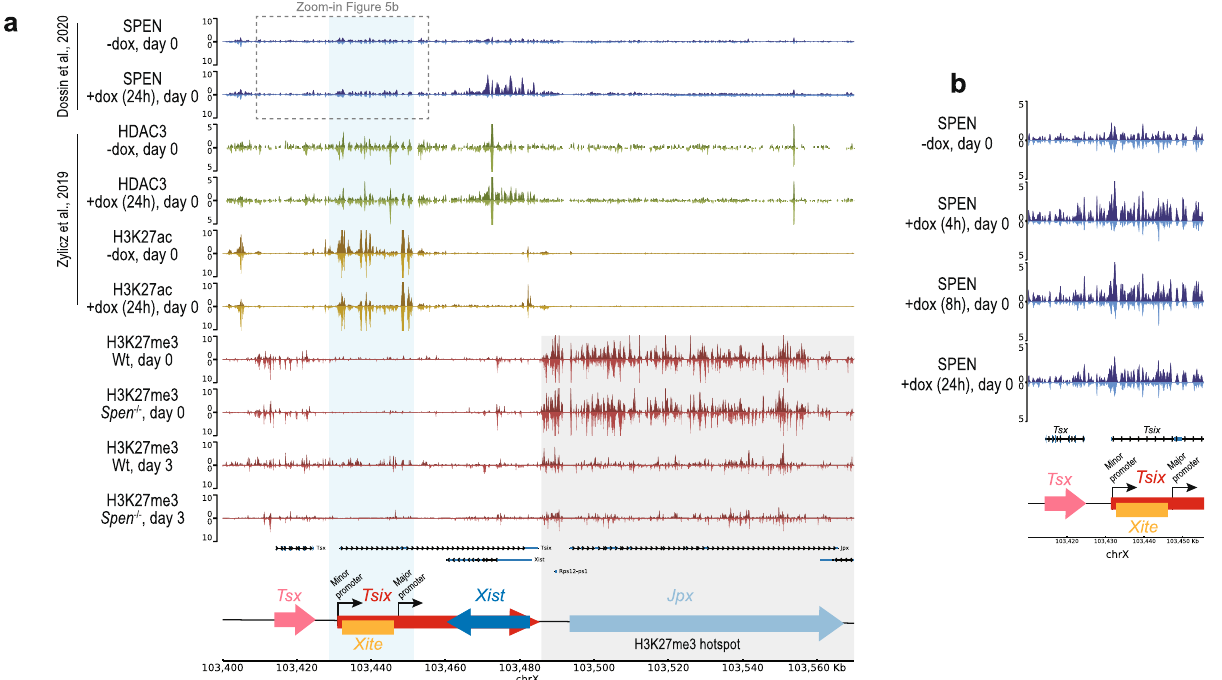
Fig. 5 Tsix -regulatory region shows SPEN, HDAC3 and H3K27ac enrichment. a Genome browser tracks showing allele-speci fi c SPEN, HDAC3, H3K27ac and H3K27me3 binding at the Xist – Tsix locus. The top part (dark) of each track represents the Xi and the bottom (light) the Xa. SPEN CUT&RUN (blue, top) pro fi le in Xist- inducible undifferentiated ESCs (day 0) untreated or treated with doxycycline (24 h) 25 . HDAC3 (green, middle – top) and H3K27ac ChIP- seq (yellow, middle – bottom) in Xist- inducible undifferentiated ESC (day 0) untreated or treated with doxycycline (24 h) 29 . H3K27me3 ChIP-seq (red, bottom) in Wt and Spen − / − ESCs at days 0 and 3 of monolayer differentiation. The light-blue rectangle highlights the Tsix regulatory region, including the Tsix minor and major promoters, and Xite . The light-gray rectangle highlights the H3K27me3 hotspot region. The dashed rectangle indicates the genomic region in (b). b Zoom-in view of the Tsix promoter region, showing the SPEN CUT&RUN pro fi le in undifferentiated ESCs (day 0) untreated or treated (4 h, 8 h and 24 h) with